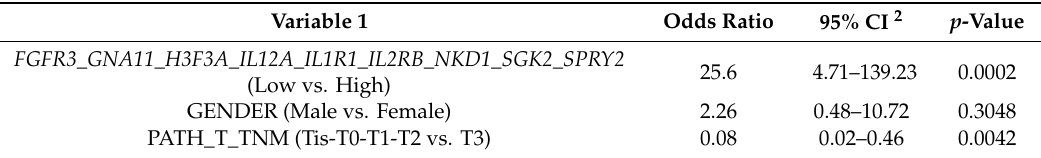
Table 3. Multivariate analysis of the association between the potential gene signatures and gender and pathological tumor staging ( p <